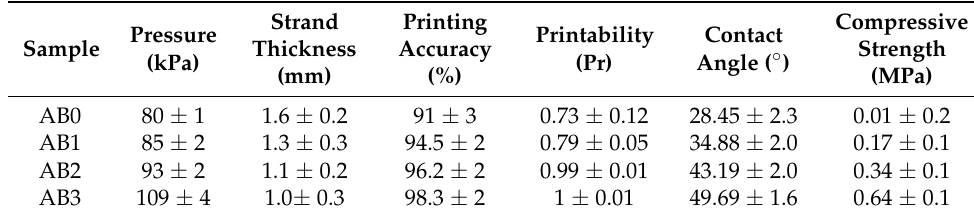
Table 2. Mean ± SD data for AB